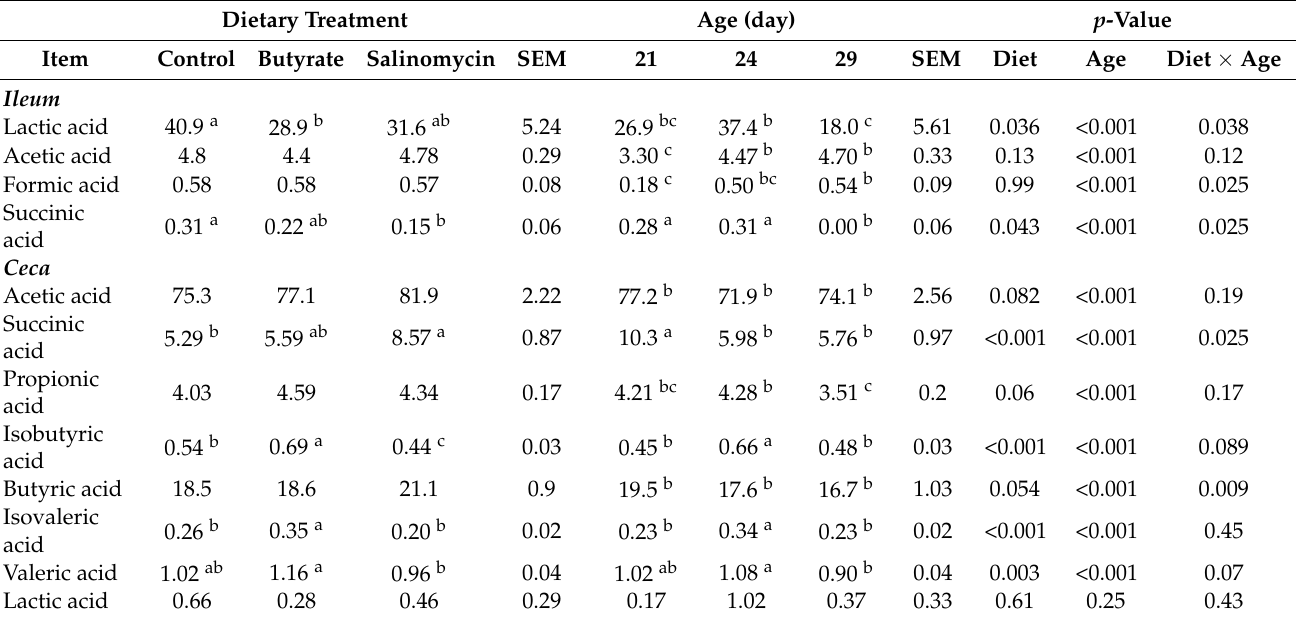
Table 3. Concentration (mmol/kg digesta) of organic acids in the ileum and ceca of broilers at different ages, fed a diet containing salinomycin, coated butyrate, or no dietary supplement (control) 1 . Dietary Treatment